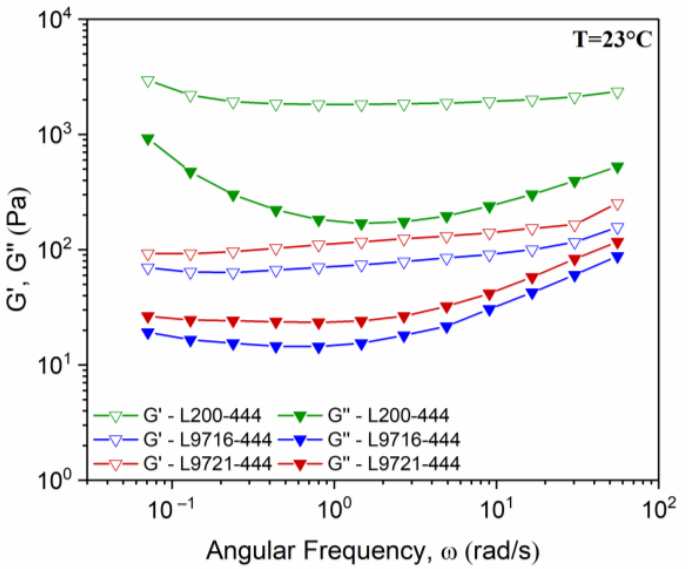
Figure 3. Oscillatory frequency tests in linear viscoelastic range for the binders with black pigment. During its lifetime and application, the liquid paint is subjected to various conditions, from rest during storage to high shear during application, and again low shear during leveling after application on the substrate. To simulate such conditions, non-destructive conditions of linear viscoelastic response were applied in the first and third steps of the experiment, while destructive conditions of high shear were applied in the second step. The results (Figure 4) showed that during the first step (rest during the storage), the binders L200 and L9716 exhibited the structure of a strong gel with extreme prevalence of the elastic modulus G (cid:48) over the viscous one G (cid:48)(cid:48) . For the binder L200, the prevalence of the elastic modulus can be observed during all three steps of the experiment. Such behavior is not preferable for, e.g., spraying applications, since during the application at high shear the paint does not flow but exhibits the properties close to solid or gel. Consequently, the homogeneous application of this paint on the substrate is unlikely. To use this binder for spraying application the addition of rheological additives for increasing viscous character at high shear would be necessary. On the contrary, the binder L9716 exhibited a stable structure at rest and liquid-like characteristics at high shear therefore we do not expect any problems during the application. However, due to the sudden recovery of the dynamic moduli to initial values at the last step of the experiment some inhomogeneities during the process of leveling on the substrate could be expected. The binder L9721 exhibited the structure of a weak gel at rest and good flow characteristics during the application; however, a higher decrease in the viscosity in this step would be preferable. Similar has already been published for TISS coatings on metal substrates